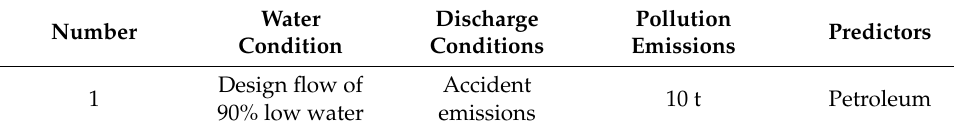
Table 1. The dock accident risk prediction